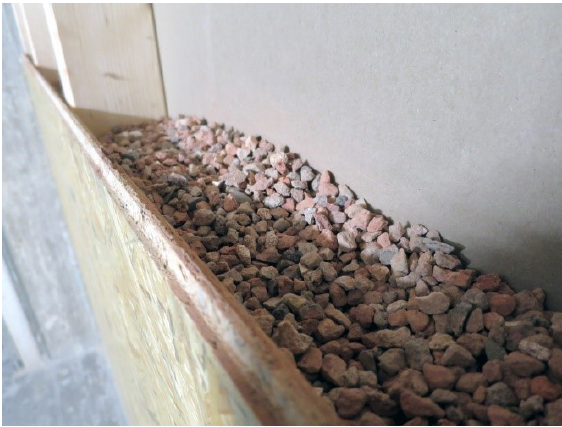
Figure 2. Crushed brick rubble in the cavity between sheathing and studs (photo by K. Staněk).